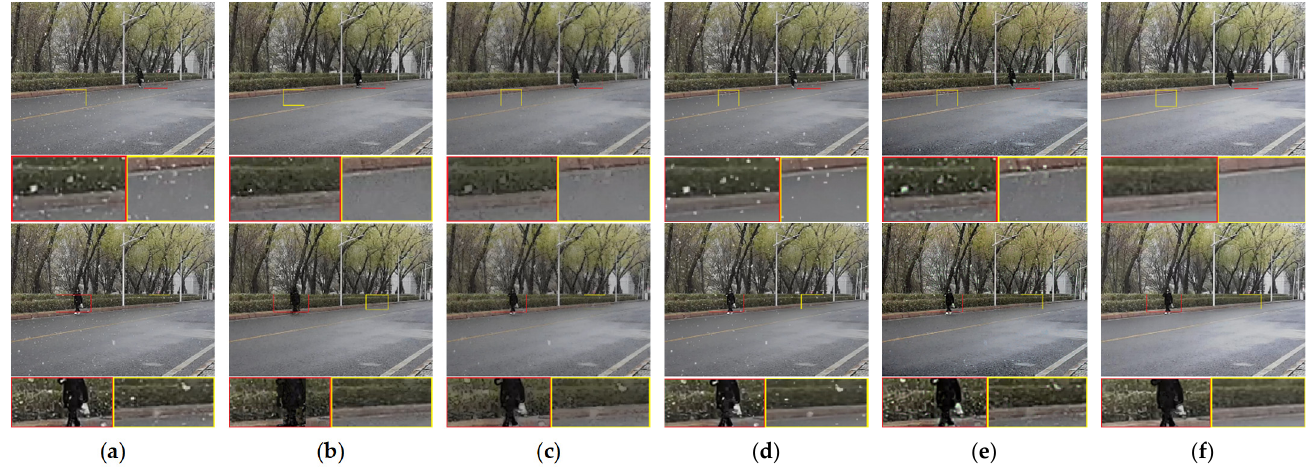
Figure 10. Comparison on a real snow video. ( a ) Input, ( b ) Kim et al. [16], ( c ) Wang et al. [8], ( d ) Li et al. [14], ( e ) Chen et al. [32], ( f ) proposed method.